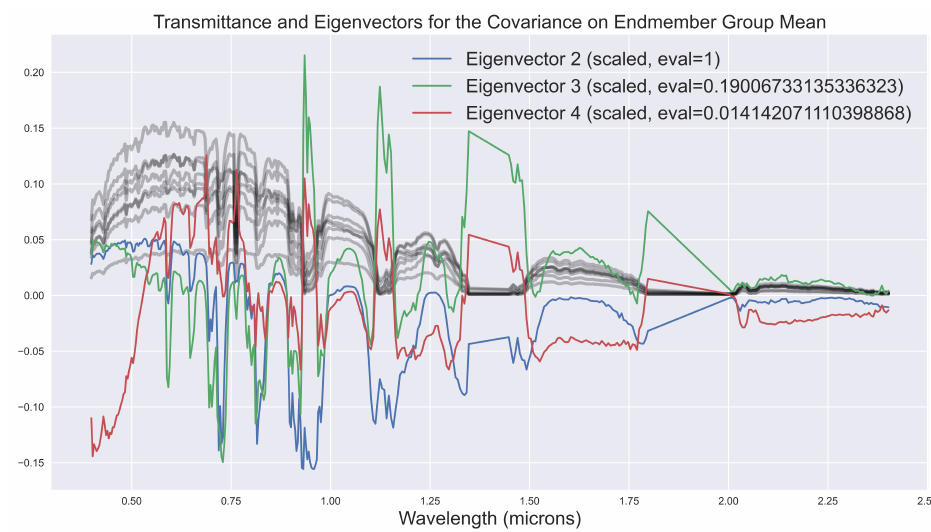
Figure 8. The transmittance for various atmospheres plotted along with the first eigenvector ( top ) and the next three eigenvectors ( bottom ) for the matrix ¯ Σ .